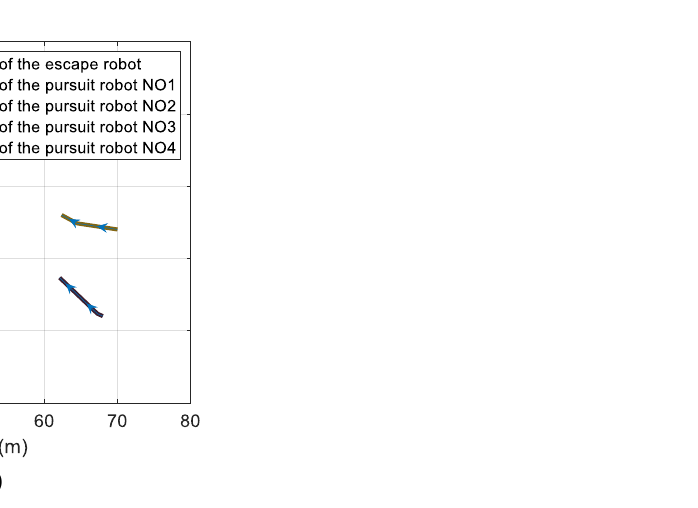
Figure 7. Pursuit robot team pursuit of the escape robot with different speeds: ( a ) V P = 1.2 m/s, V E = 1 m/s, and successful capture; ( b ) V P = 1 m/s, V E = 1 m/s, and successful